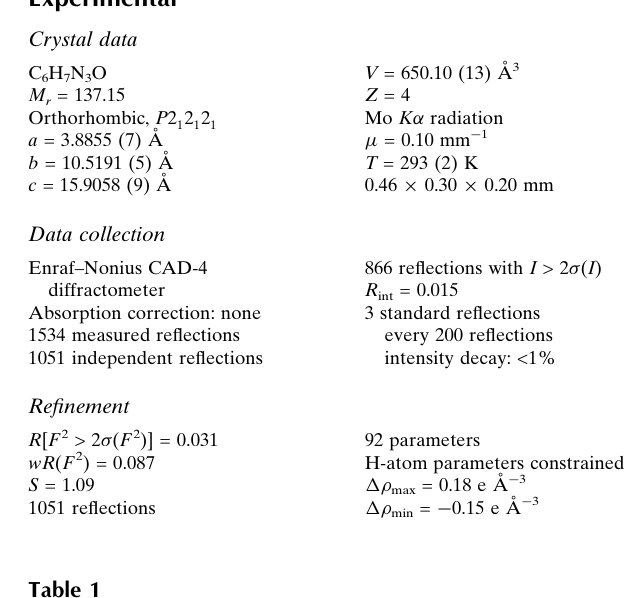
Hydrogen-bond geometry (A˚ , (cid:1)